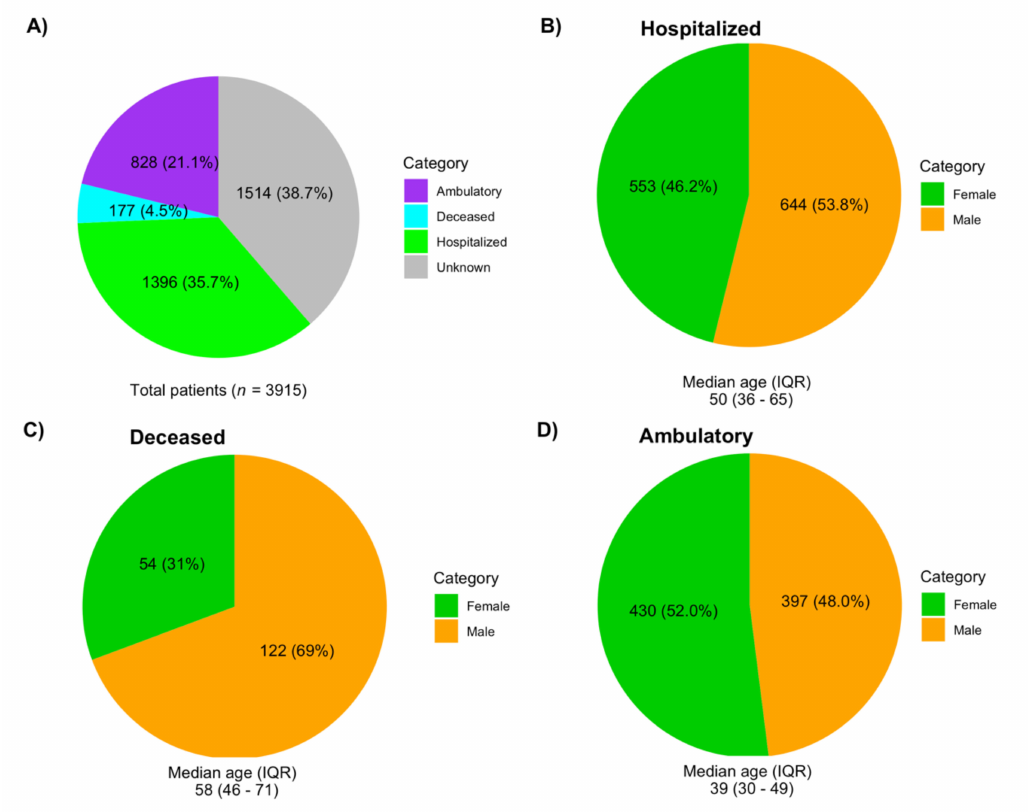
Figure 2. Demographic data of the 3915 patients whose genomes were included in this study. ( A ) Types of patients. ( B ) Gender composition of hospitalized patients. ( C ) Gender composition of deceased patients. ( D ) Gender composition of ambulatory